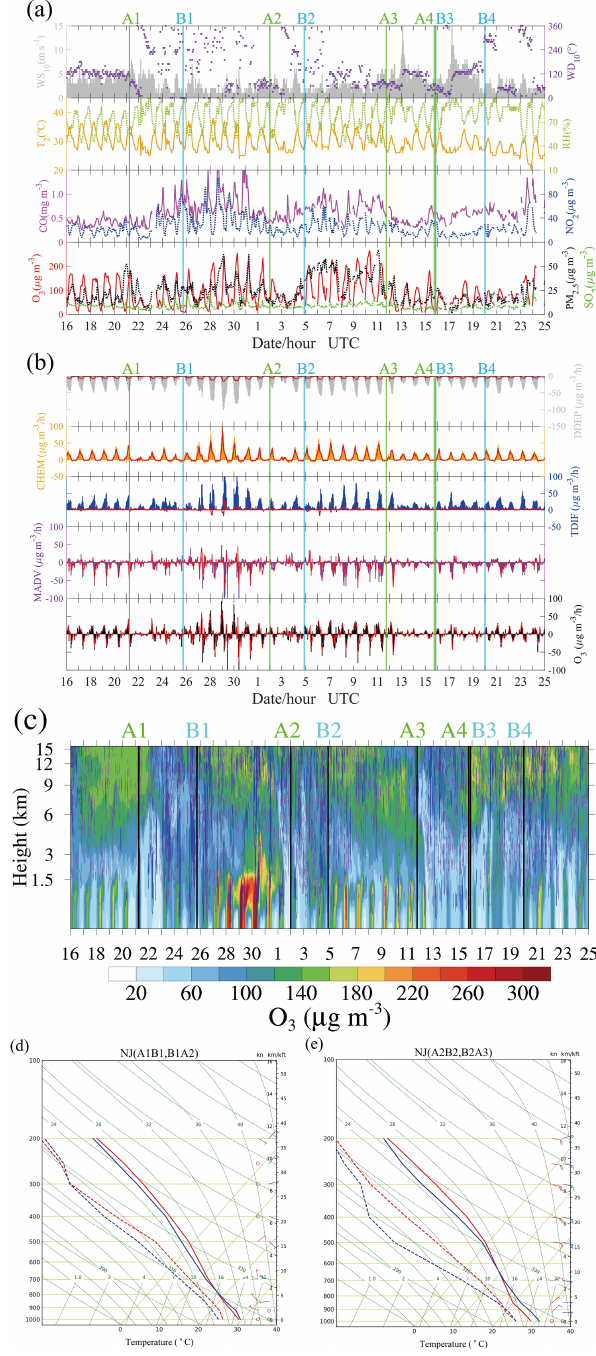
Figure 9. Same as Fig. 6 but for